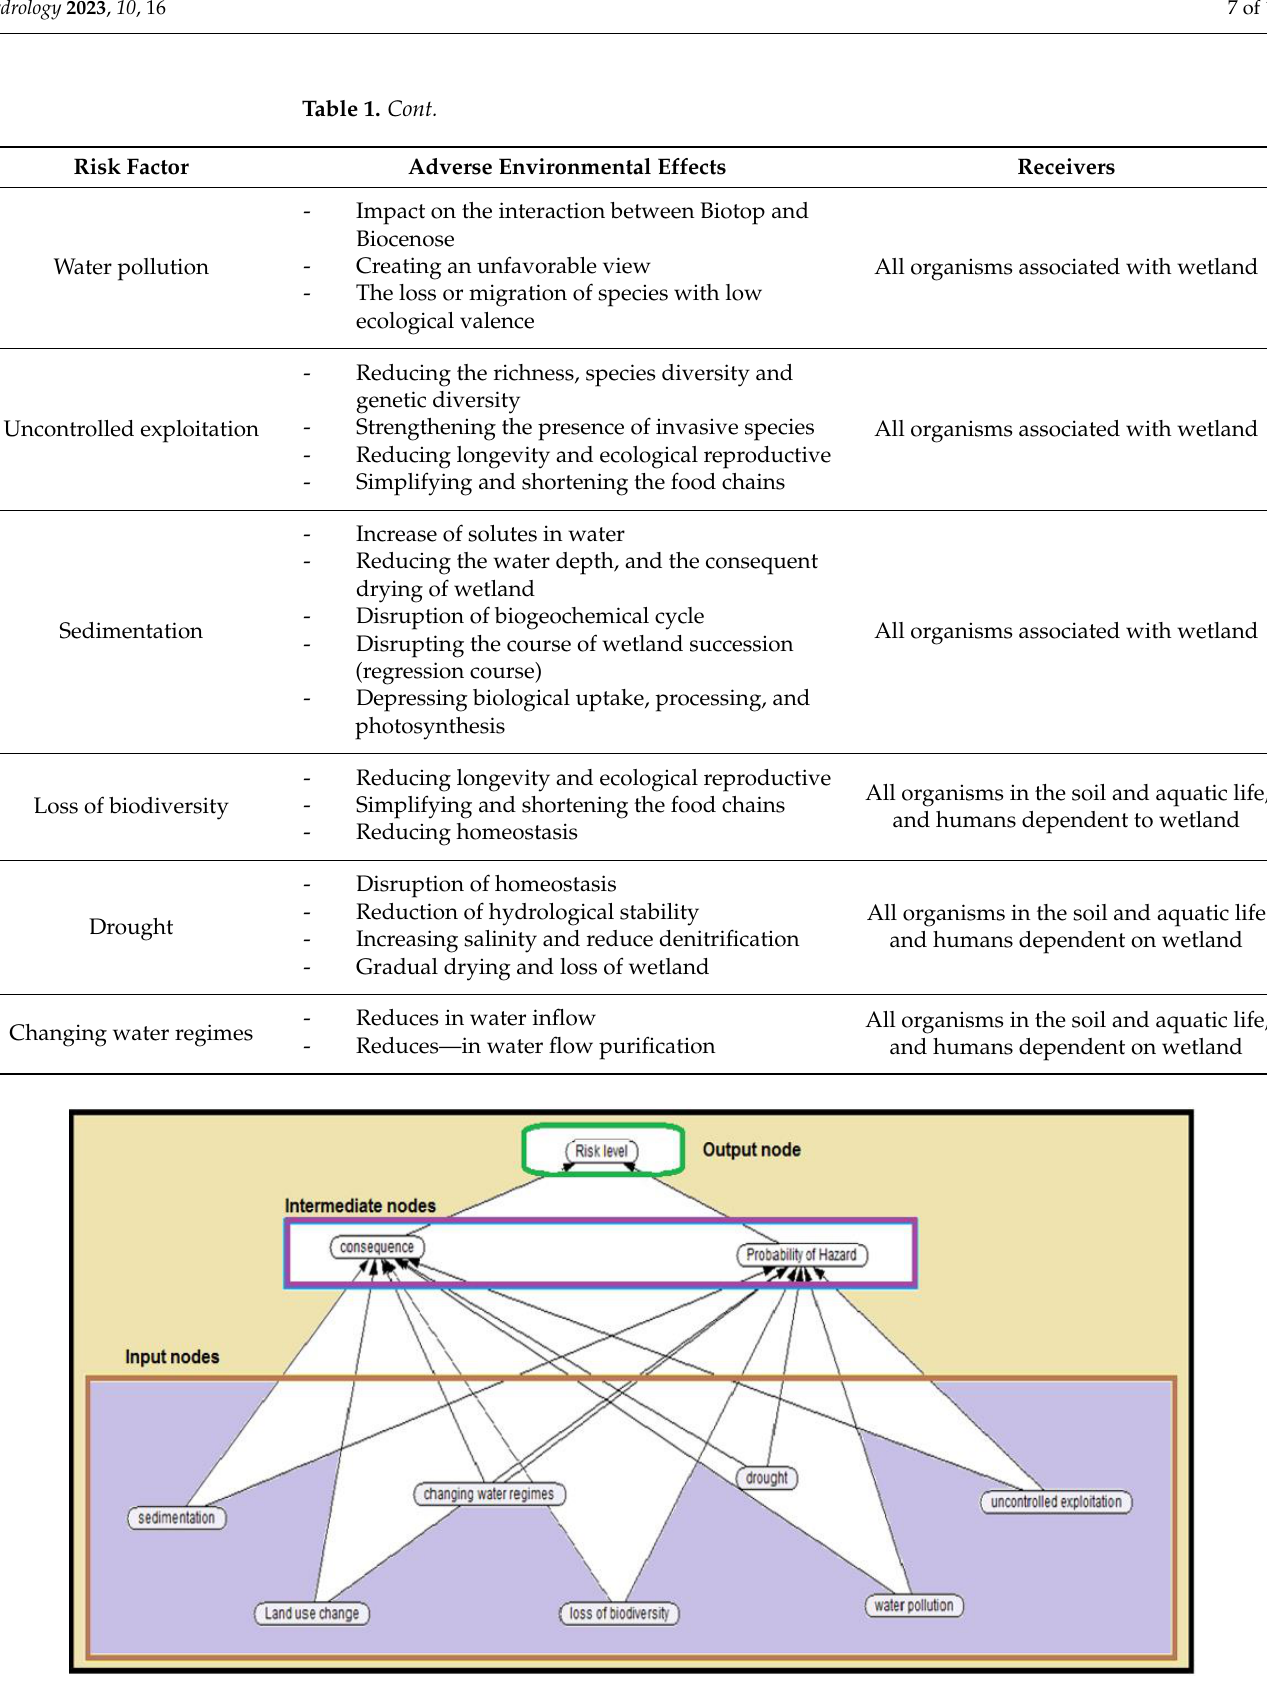
Figure 3. Parameters used in BBNs ’ model to determine the levels of environmental risks at SIWs. Table 1. Characteristics of the risk factors in SIWs. Following the completion of the ID setup, the states of each node were determined to form the initial BBN model. A range of states were considered for each node based on